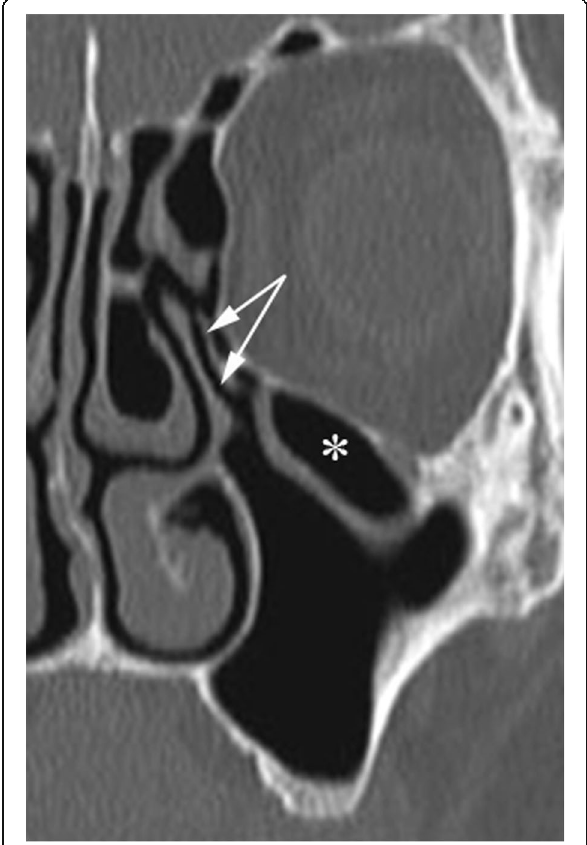
Fig. 2 Haller ’ s cell. Coronal MDCT reformation shows a huge infraorbital cell (asterisk) along the inferior orbital wall, not affecting the caliber of the ethmoid infundibulum